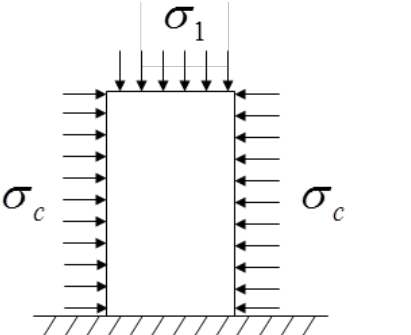
is the applied circumferential confining pressure. 𝑐